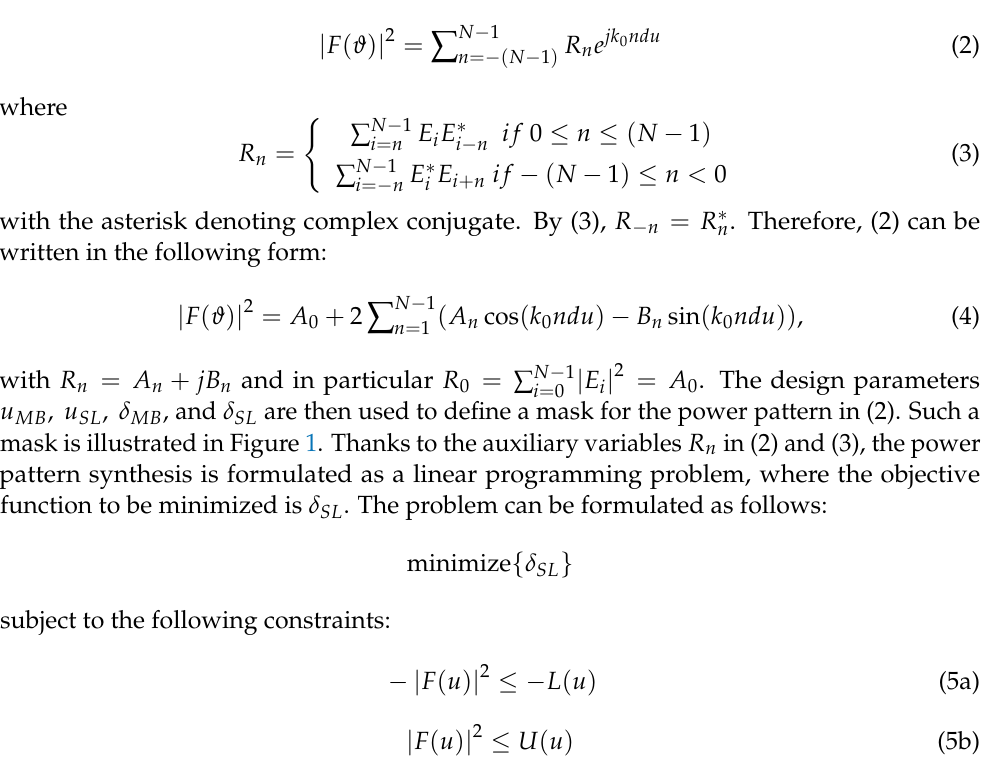
Figure 1. Example of a constraints compliant radiation pattern and definition of the design parameters 𝑢 𝑀𝐵 , 𝑢 𝑆𝐿 , 𝛿 𝑀𝐵 , 𝛿 𝑆𝐿 , and Δ𝑢 for the flat-top power pattern.